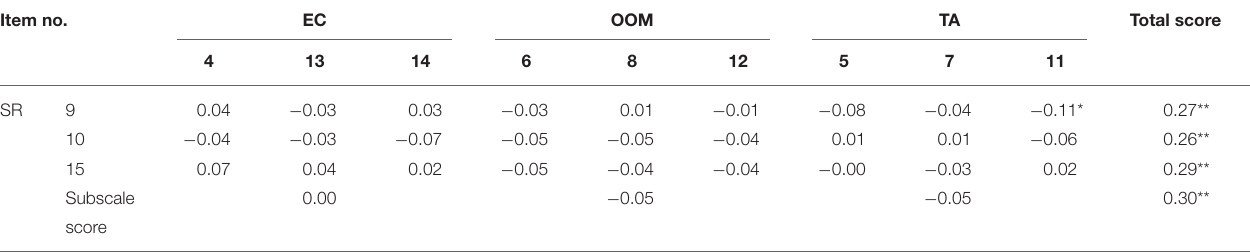
TABLE 3 | Correlation matrix of SR subscale and EC, OOM, TA subscales and total score of FS-12. Item no.